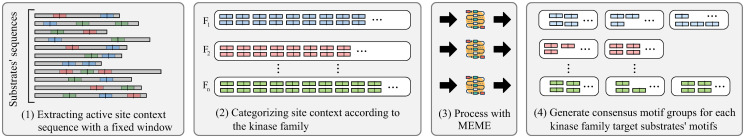
High-level workflow of generating predicate labels for the phosphorylation knowledge graph based on motifs extracted from the context sequences of phosphorylation sites by means of the MEME tool.